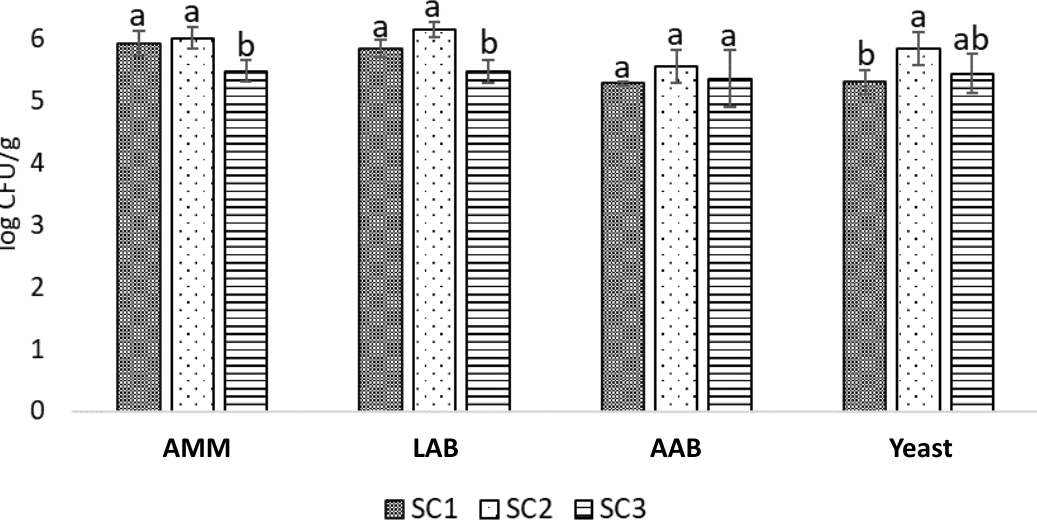
Figure 1. Microbiological group levels in ST kombuchas fermented using SCOBYs 1, 2, and 3 (SC1, SC2, SC3). Different letters show statistical significance ( p ≤ 0.05) between different SCOBYs (a–b).